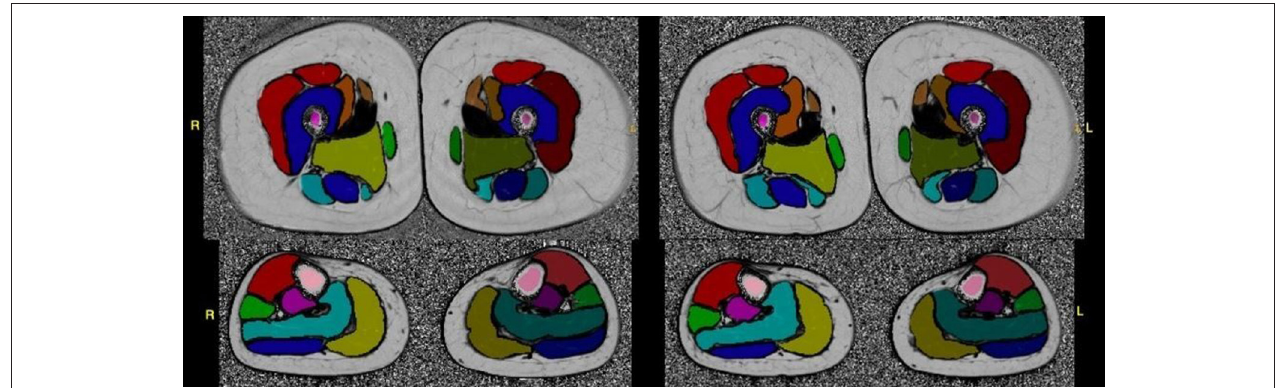
FIGURE 2 | Test-retest fat-fraction map images from an example healthy volunteer for the calculation of reproducibility metrics. Images were acquired at two time points, 2 weeks apart. The fat fraction map was calculated from three-point Dixon acquisitions using the MRI study protocol, and shown with the placement of the whole muscle ROIs overlaid on the slice. All images were windowed to the same range for display (0–100%).